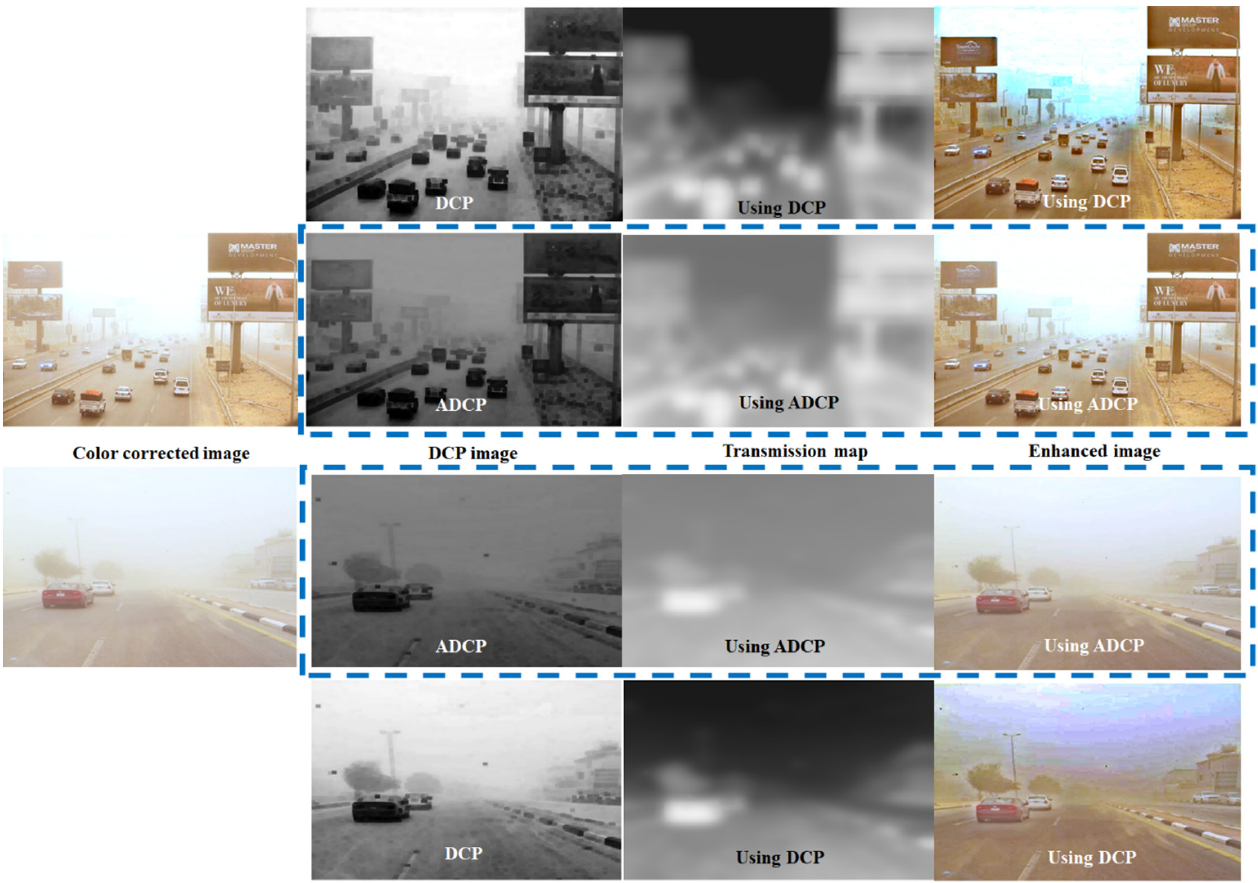
Figure 3. The comparison with DCP [1] and the proposed ADCP and their transmission map and enhanced image (Blue dotted line indicates the proposed method).